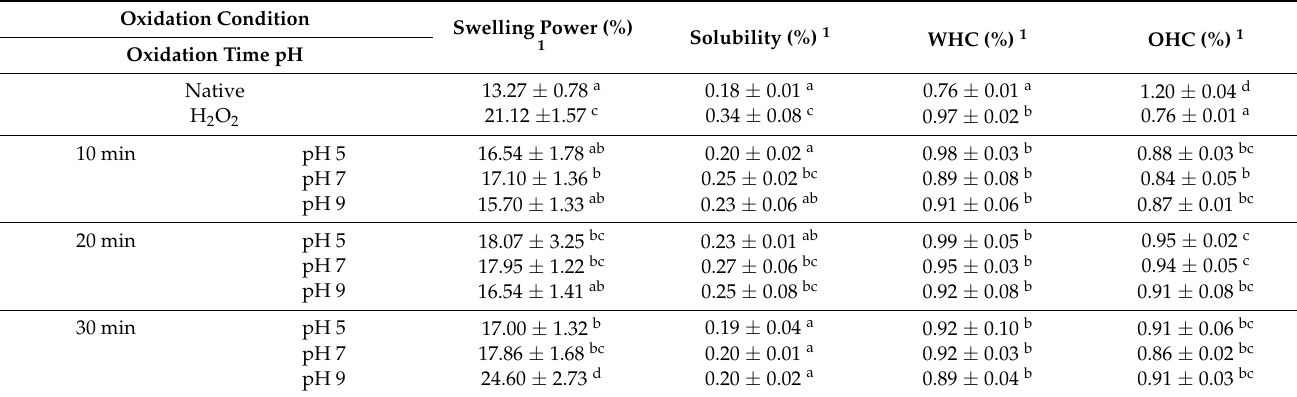
1 Mean ± standard deviation. Values with different superscript letters in the same column indicate significant difference ( P <